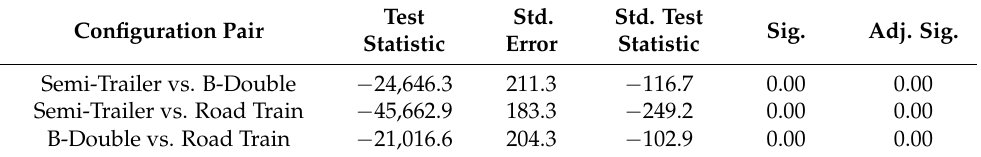
Table 7 . Net payload pairwise comparison of configurations for being the same distribution .